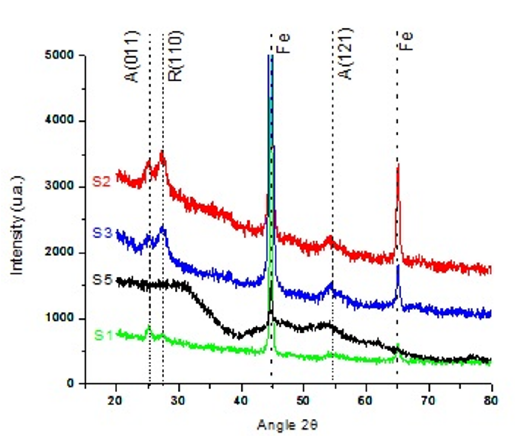
thin films deposited at different 2